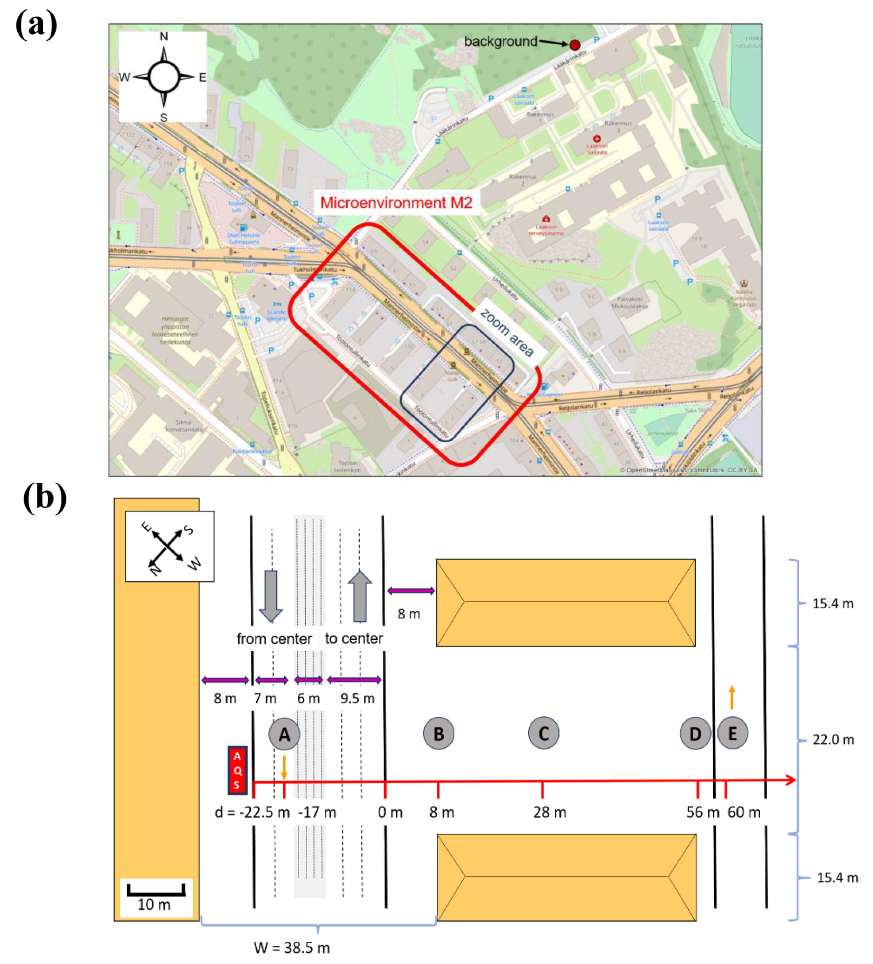
Figure 8. Urban Case microenvironment M2: (a) map showing microenvironment M2, the street canyon zoom area, and the background measurement location. © OpenStreetMap contributors 2021. Distributed under the Open Data Commons Open Database License (ODbL) v1.0 (see http://www.openstreetmap.org/, last access: 14 June 2021). (b) The horizontal geometries and Sniffer measurement locations in the M2 zoom area. The red arrow shows the distance d from curbside in metres